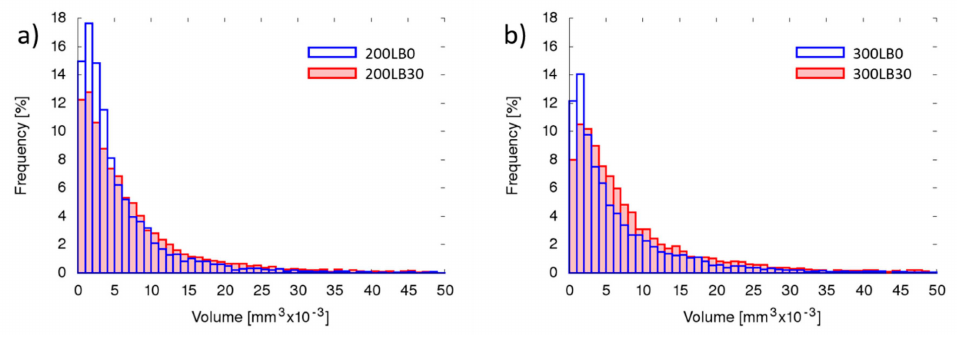
Figure 5. Pores volume for ( a ) I ISO = 200 and ( b ) I ISO = 300.